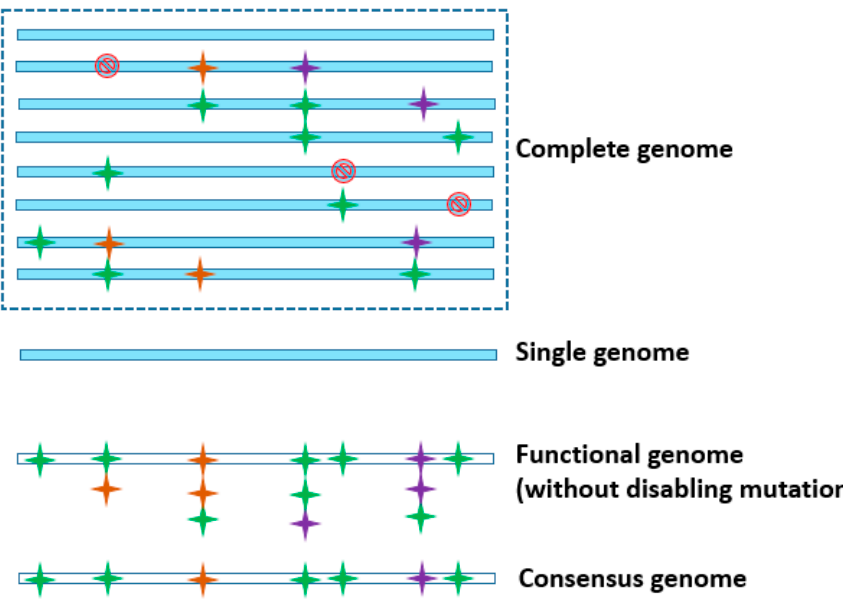
Figure 2. Different forms of a reference genome. The horizontal bars represent the DNA sequence of a genome. represents a disabling mutation that disrupts the gene function. , , and depict various sequence polymorphisms.